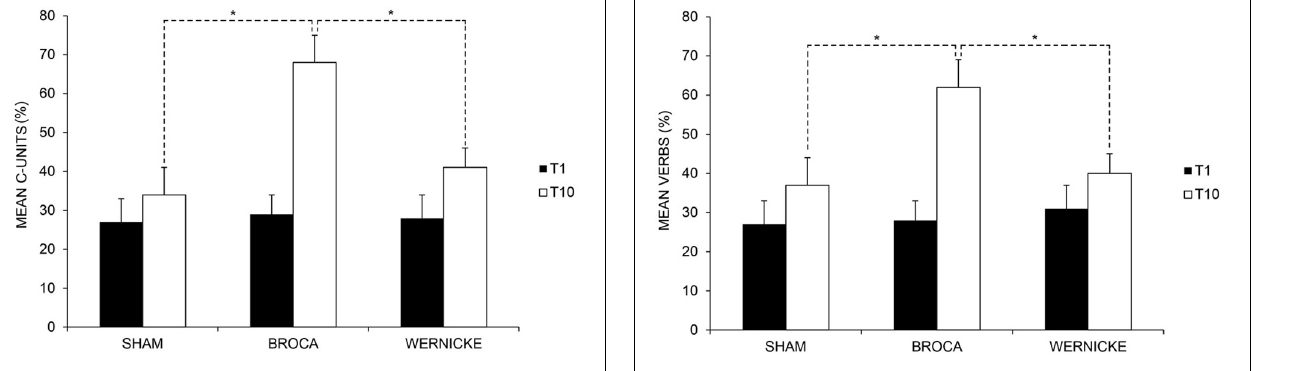
FIGURE 4 | Mean percentage of correct verbs at baseline (T1) and at the end of treatment (T10) for the left anodic Wernicke’s, Broca’s and sham conditions ( ∗ < 0.01), respectively. Error bars represent standard error of the